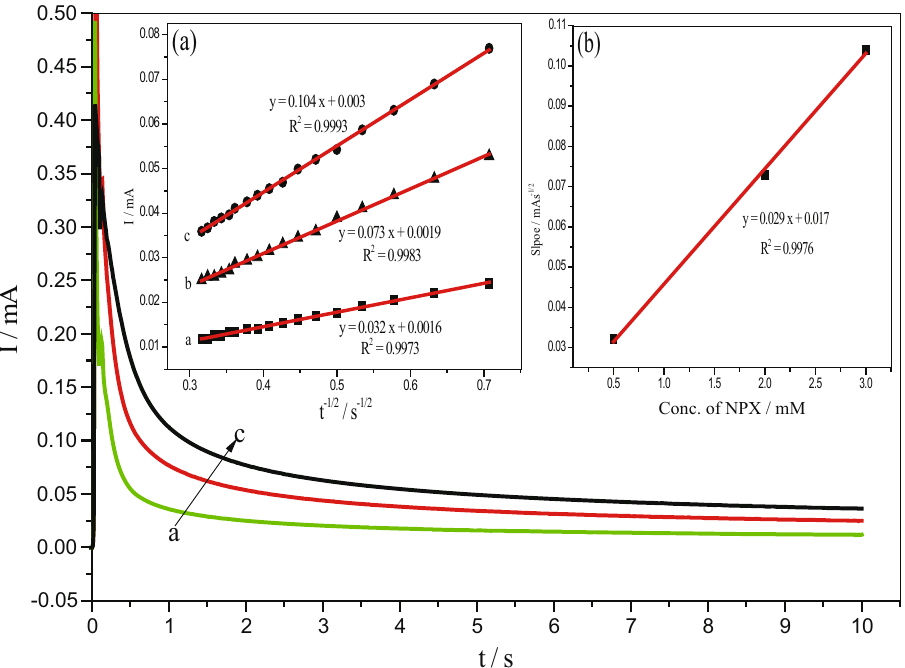
Figure 8: Chronoamperograms obtained at the poly ( r - o - NBA ) /GQDs/CPE in 0.1 M of PBS ( pH = 7.0 ) for di ff erent concentrations of NPX from a to c ( 0.5, 2.0, and 3.0 mM ) . Insets: ( a ) plot of I versus t − 1/2 and ( b ) plot of the slope of straight lines versus NPX concentration.